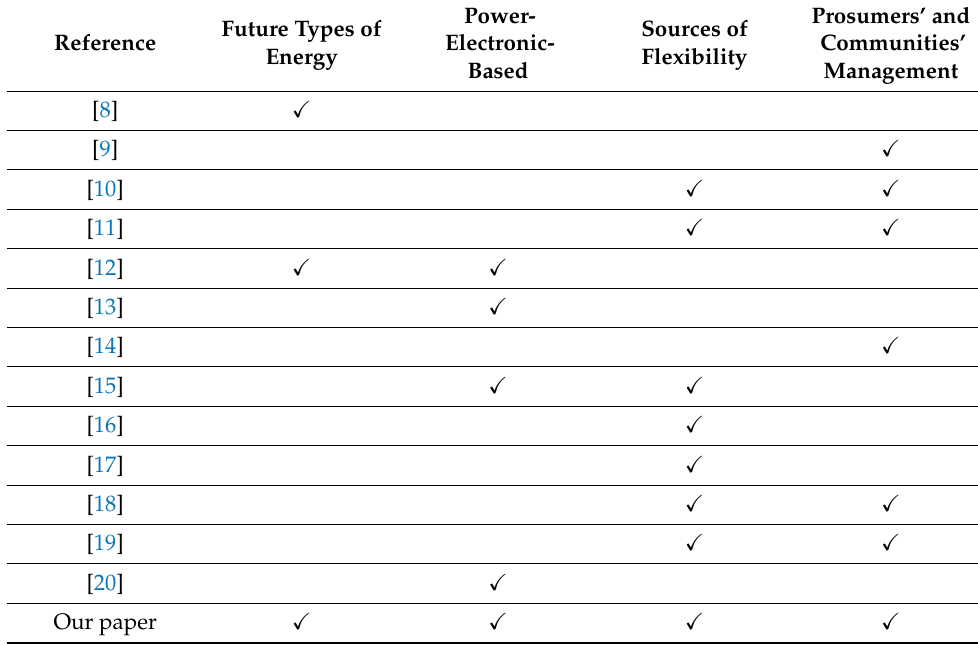
Table 1. Some existing works discussing solutions for future power